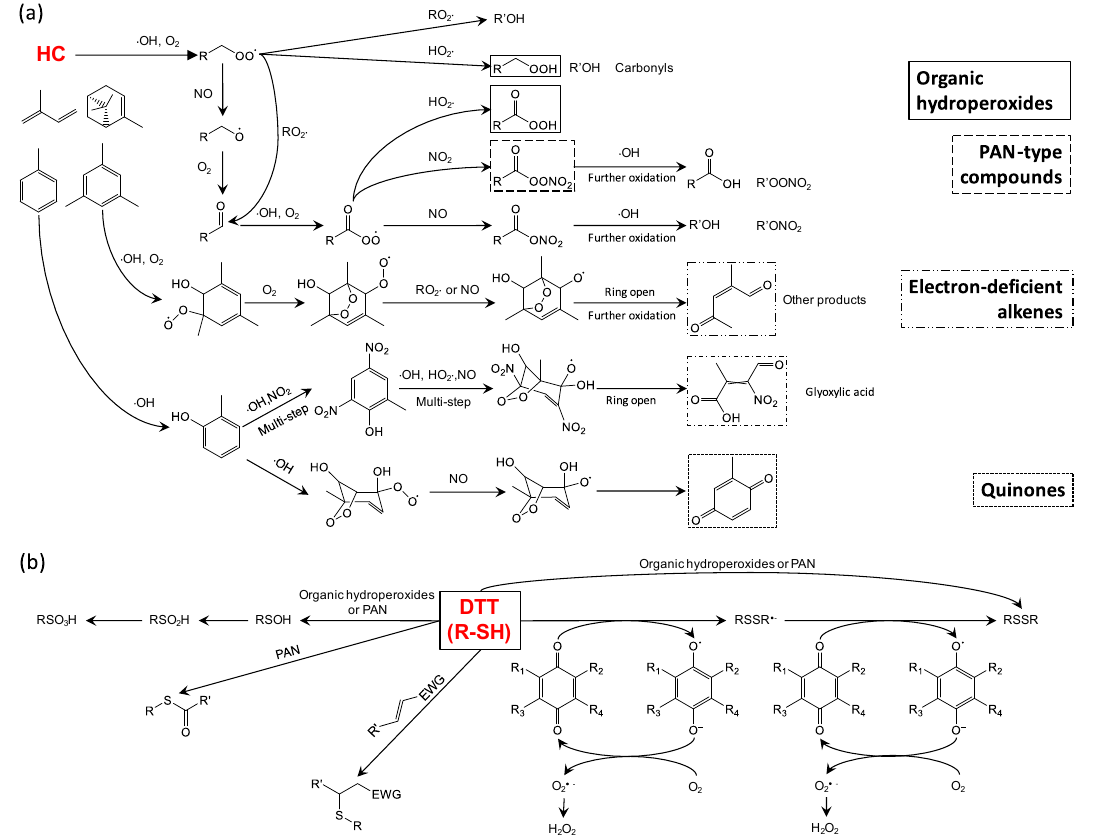
Figure 1. (a) Simplified mechanisms for the formation of alkyl and acyl hydroperoxides, PANs, electron-deficient alkenes, and quinones (Eddingsaas et al., 2012b; Jang and Kamens, 2001; Saunders et al., 2003, 1997; Wyche et al., 2009; Xu et al., 2014). Photooxidation products are not limited to the compounds shown. (b) Possible reaction mechanisms between sulfhydryl groups in DTT (represented by R-SH) and SOA products (Grek et al., 2013; Kumagai et al., 2002; Mudd, 1966; Mudd and McManus, 1969; Nair et al., 2014). EWG represents the electron-withdrawing group attached to an